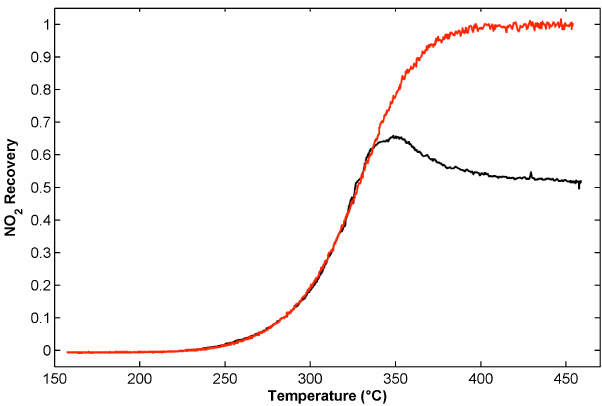
Figure B1. A graph showing the NO 2 recovery as a function of temperature. The NO 2 recovery with addition of O 2 in the TD-LIF is shown in red, and in black is NO 2 recovery without addition of O 2 . Conversion of isopropyl nitrate is 100% in the